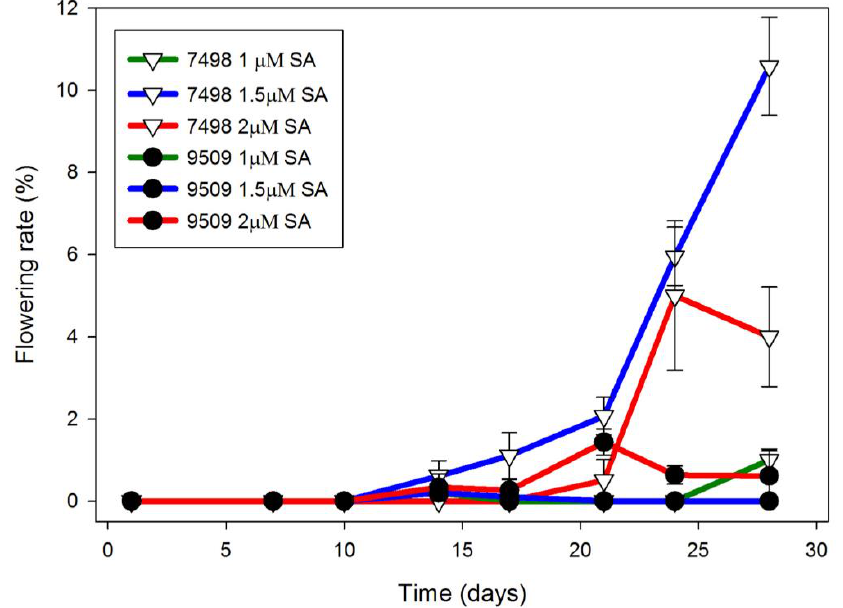
Figure 1. Flowering rate of S. polyrhiza strain 7498 cultured on Hg was increased to a much greater extent by SA than that of strain 9509. Plants were grown in Petri dishes inoculated with three 3-frond colonies from 4-week-old cultures growing on Hg without SA. Optimal flowering for strain 7498 was observed in the presence of 1.5 µ M SA. Data are the average ± SEM ( n = 3). Occasionally, abnormal flowers were seen in Petri dish cultures. Unusual kidney shaped fronds of strain 7498 produced flowers that did not appear to emerge from the normal location on the frond (Figure 3A). Strain 9509 occasionally produced flowers with what appeared to be the purple ventral side of the frond overgrowing and covering the anthers (Figure 3B). On this frond, a rhizoid, which would normally grow from the ventral surface of the frond, is growing vertically up out of the medium. Completely detached, aborted developing pistils and anthers enclosed in the spathe were found floating in strain 9509 cultures (Figure